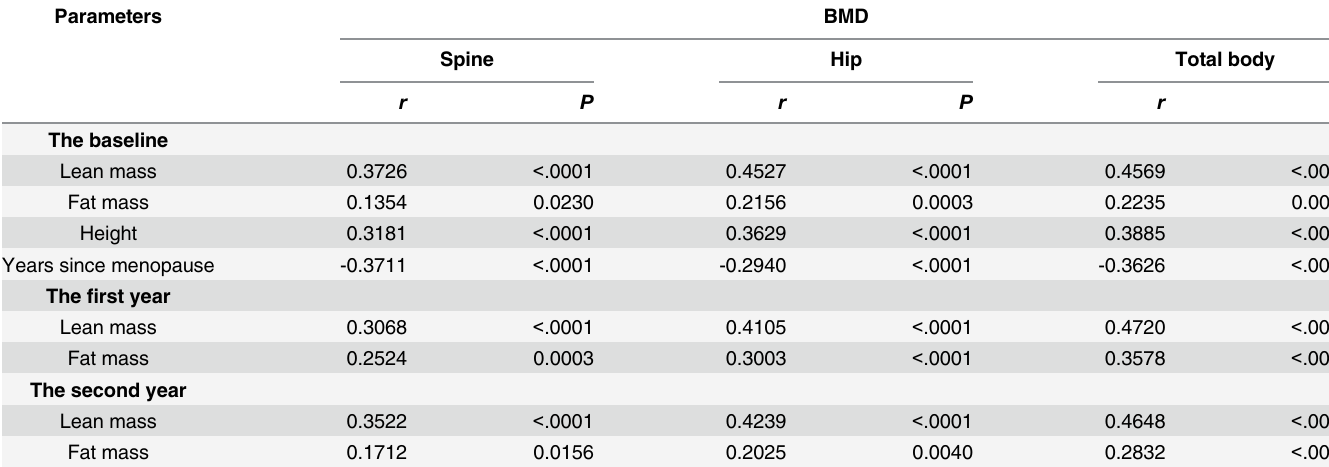
Table 2. Correlation of BMD of the spine, hip, and the total body with body composition at baseline and follow-up (adjusting for calcium supplementation). Parameters